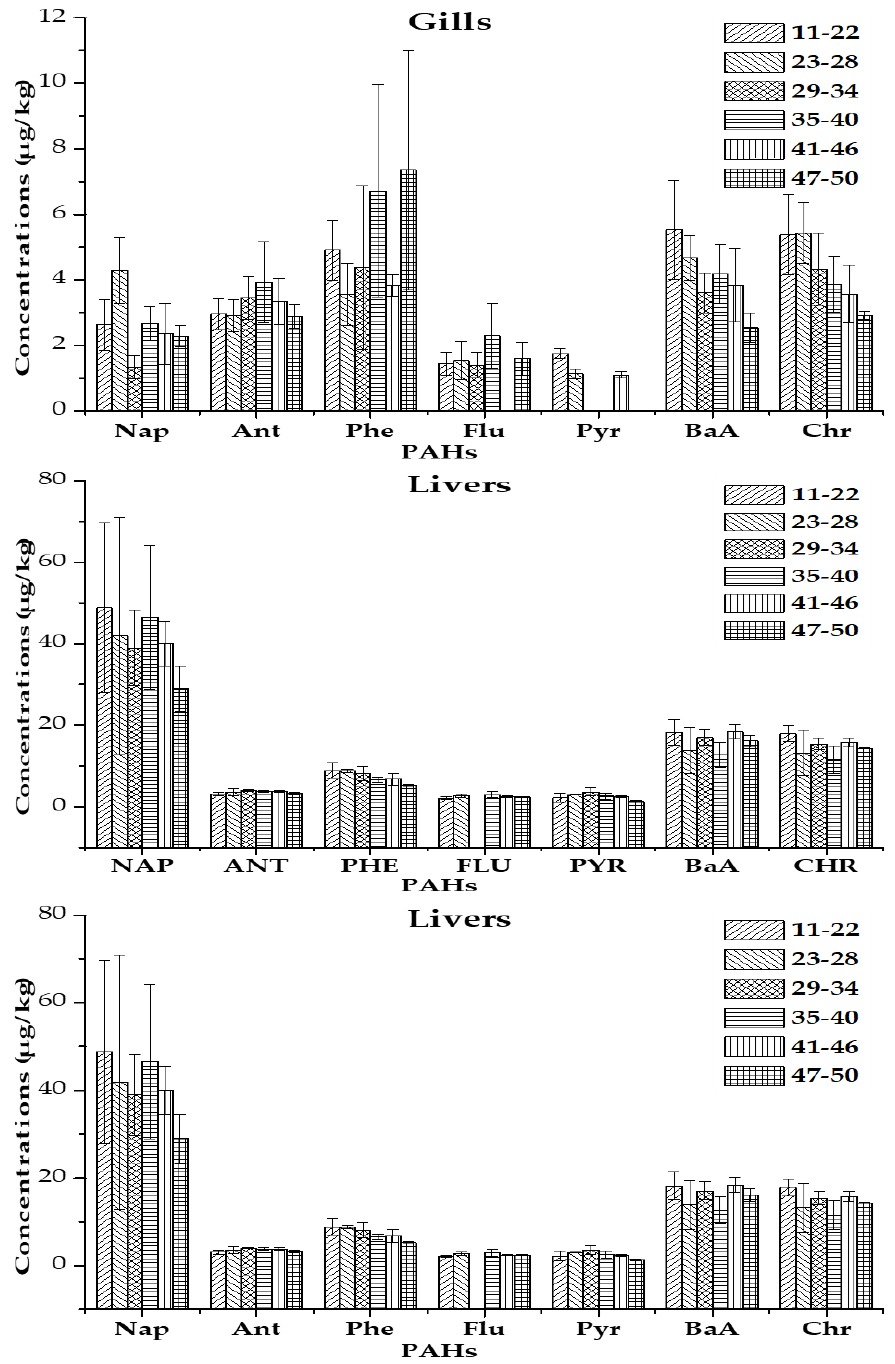
Figure 6. Variation of PAH contents according to size classes of fish.